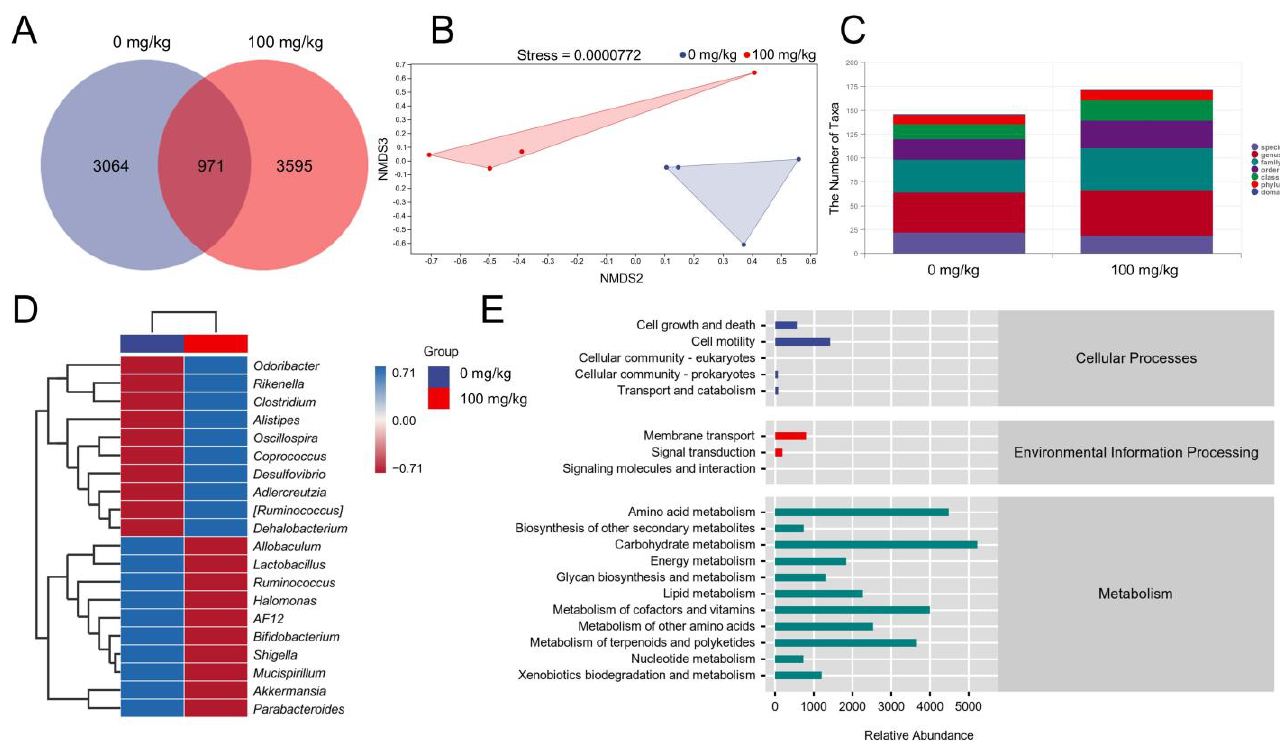
Figure 2. IHS modulates the gut microbiota of Apc Min/+ mice. ( A ) Venn diagram; ( B ) Nonmetric multidimensional scaling of weighted UniFrac distances according to beta diversity analyses; ( n = 4); ( C ) Analysis of the number of classification units; ( D ) Heatmap of gut microbes at the top 20 genus level based on relative abundance; ( E ) Predicted abundance graph of Kyoto Encyclopedia of Genes and Genomes (KEGG) secondary functional pathways; x-coordinate: relative abundance of functional pathways; y-coordinate: KEGG secondary functional pathways and the rightmost is the first level pathway to which the pathway belongs.